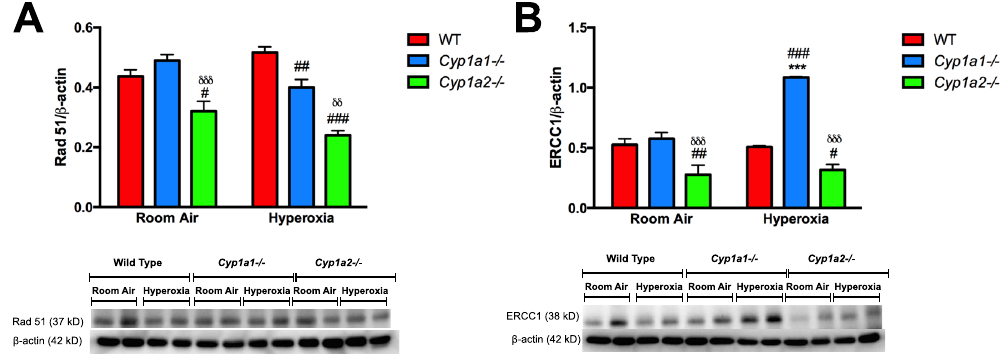
Figure 7. Effect of hyperoxia on Rad 51 ( A ) and ERCC1 ( B ) protein expression in WT, Cyp1a1 − / − and Cyp1a2 − / − mice in room air and after 48 h of hyperoxia. For western blotting, lung whole protein (20 μ g of protein) from individual animals (n = 4/group) exposed to room air or to hyperoxia for 48 h. For loading controls, the membranes were stripped and incubated with antibodies against β -actin, followed by electrochemical detection of bands. Two way ANOVA was used to assess statistical significance in protein expression among genotypes and the effect of hyperoxia. Significant differences from room air controls are represented by ** p < 0.01 and *** p < 0.001. Significant differences in expression compared to levels in WT mice is represented by # p < 0.05, ## p < 0.01 and ### p < 0.001. Significant differences in expression compared to levels in Cyp1a1 − / − mice is represented by δ p < 0.05, δδ p < 0.01 and δδδ p <